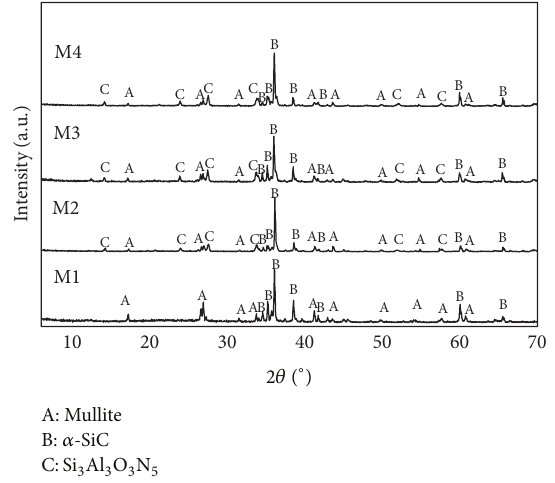
Figure 1: XRD patterns of samples with different silicon powder addition nitridation sintered at 1500 ∘ C for 3 h.